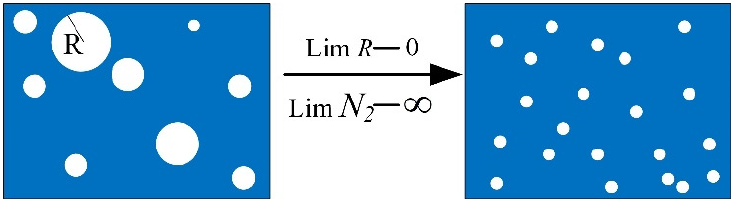
Figure 3. Schematic diagram of homogeneous model [38].